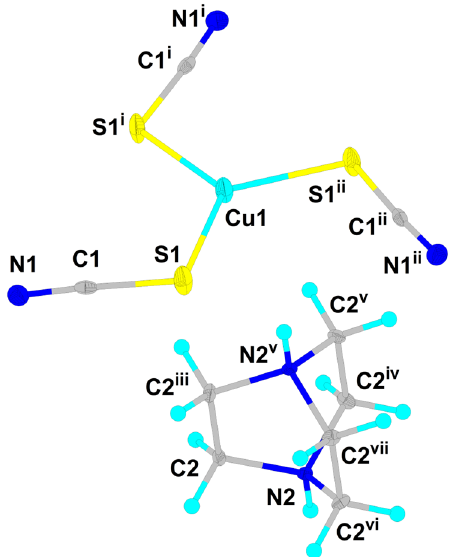
Figure 3. Independent part of structure 2 . Thermal ellipsoids are drawn at the 50% probability level.